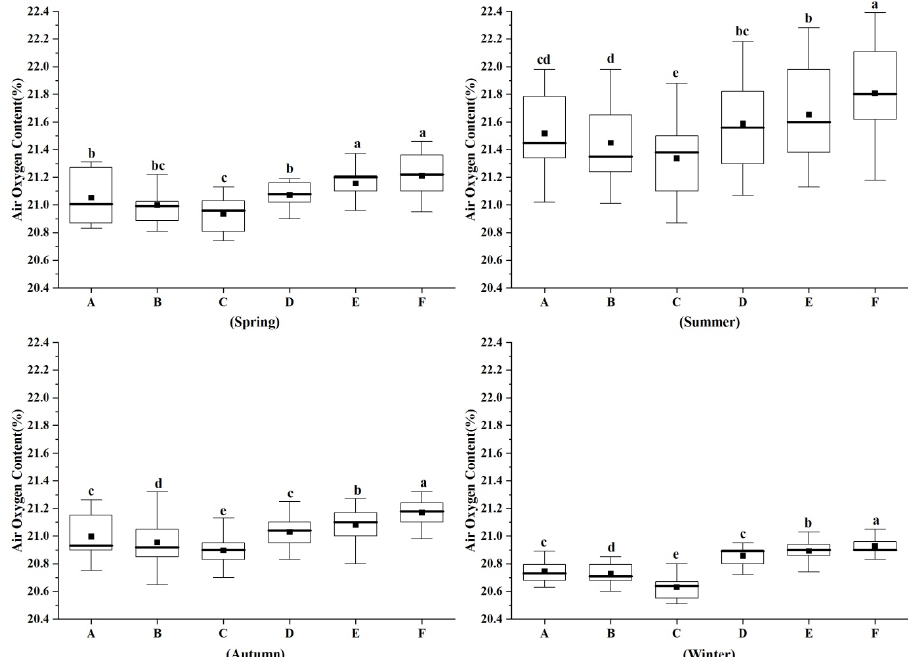
Figure 6. Comparison of air oxygen content in different forest types. A— Phyllostachys edulis forest; B—Subtropical evergreen broad-leaved forest; C—Forestless control group; D— Liquidambar formosana forest; E— Cunninghamia lanceolata forest; F—Coniferous and broad-leaved mixed forest. The different lowercase letters indicate significant difference among the stand types in the same time ( p <